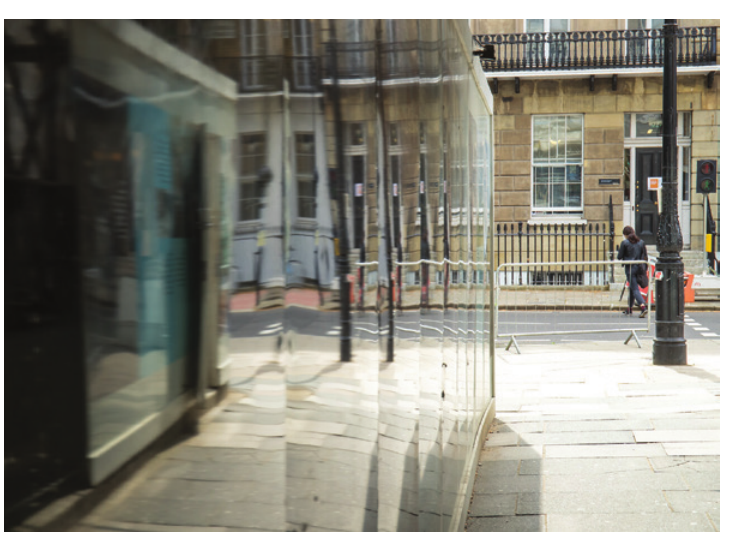
Figure 12 Reflections in building site hoardings (Source: photograph by UCL Digital